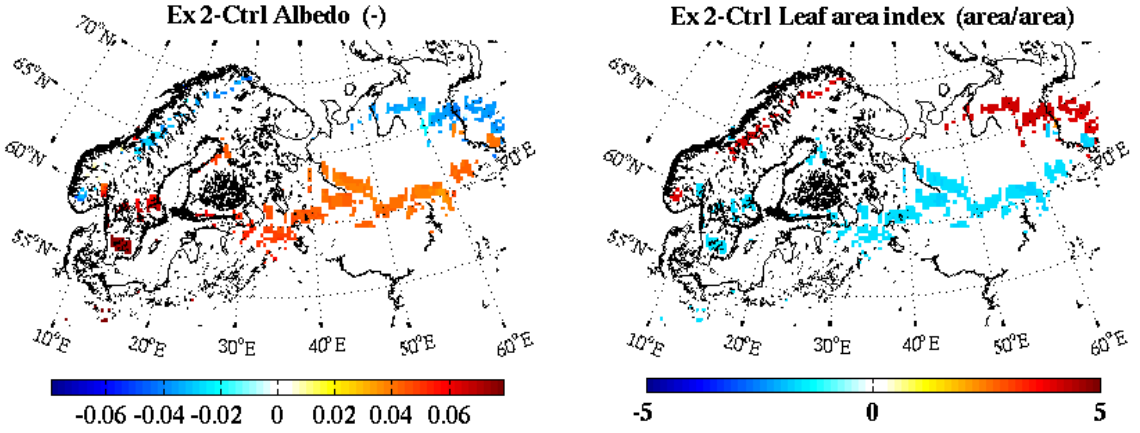
Figure 3. Changes in 10-year average albedo (left panel) and LAI (right panel) for Ex 2 (including all vegetation changes), as compared to the control